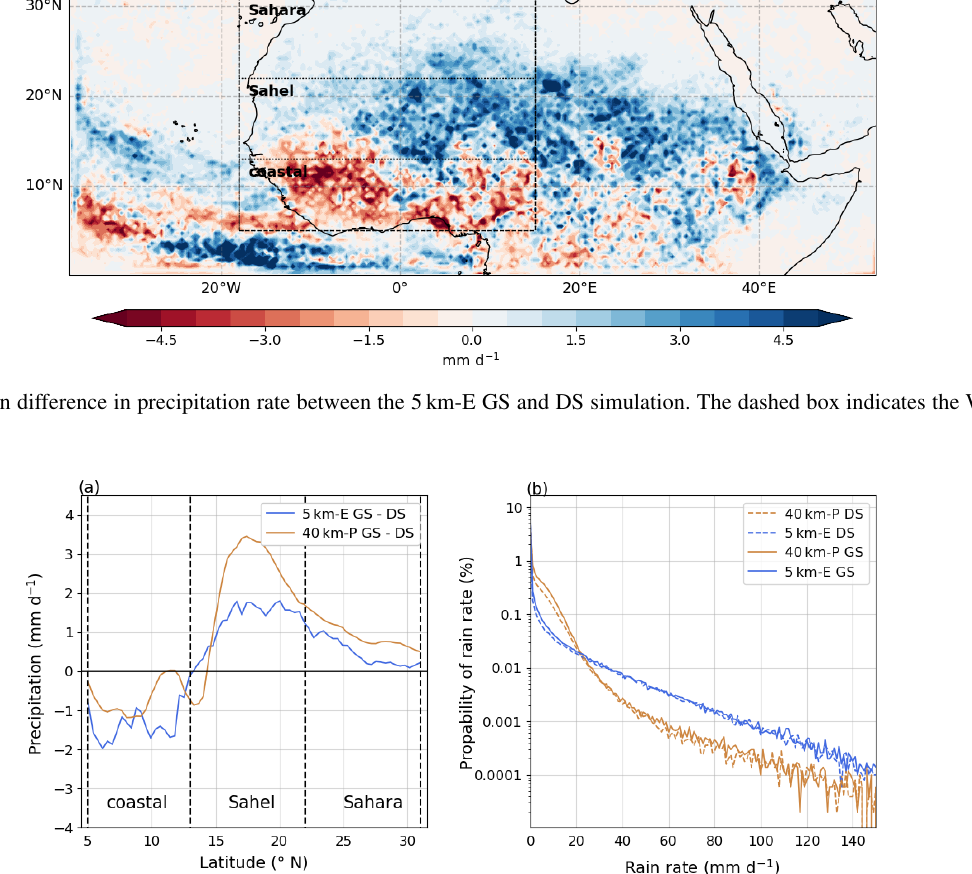
Figure 9. (a) Difference of the JAS mean meridional precipitation distribution between the GS and DS simulation for the 5km-E simulations (blue line) and the 40km-P simulation (orange line), respectively. The vertical black dashed lines indicate the borders of the coastal, the Sahel, and the Sahara region outlined in Fig. 1. Panel (b) shows the probability density function of rain rate calculated over all land points of the WA domain. Blue lines indicate the 5km-E DS (dashed) and GS (solid) simulations. Orange lines display the 40km-P DS (dashed) and GS (solid)